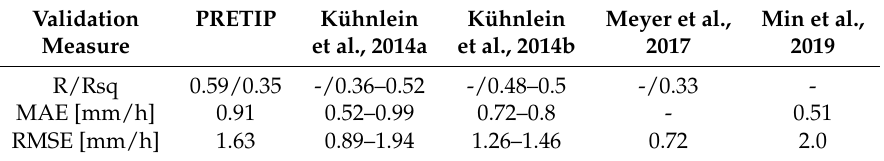
Table 3. Comparison of the validation measures of PRETIP with other